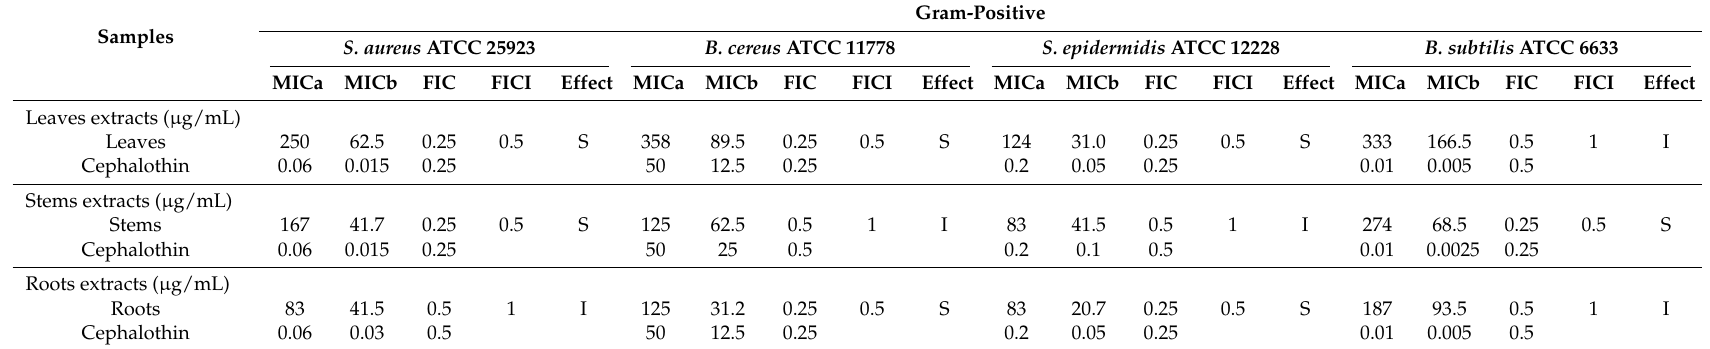
Table 4. Fractional inhibitory concentration index (FICI); combination of alkaloid extract of B. microphylla with cephalothin.